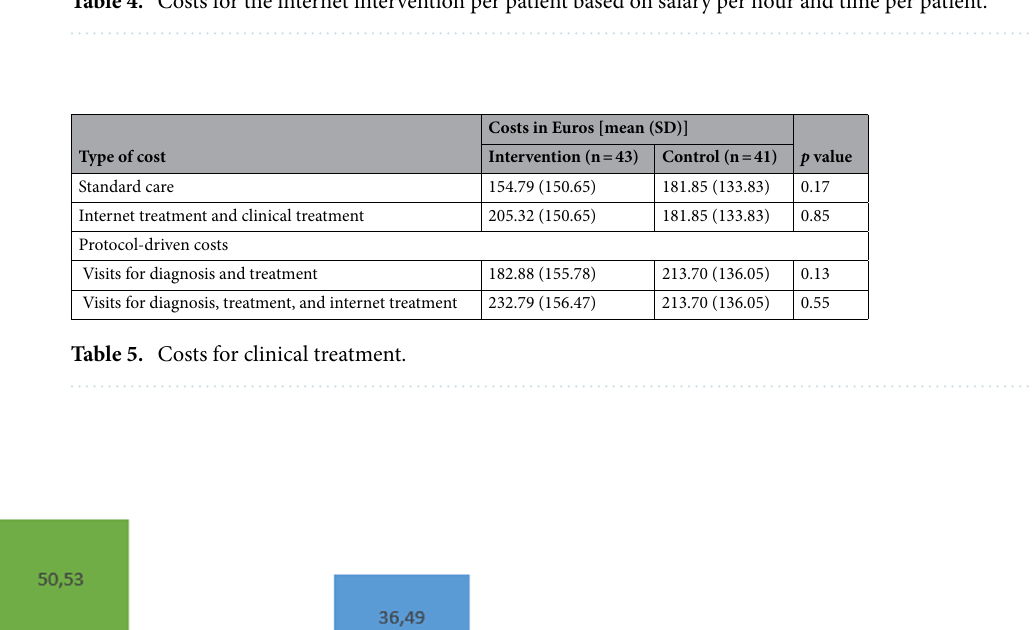
Table 4. Costs for the internet intervention per patient based on salary per hour and time per patient.